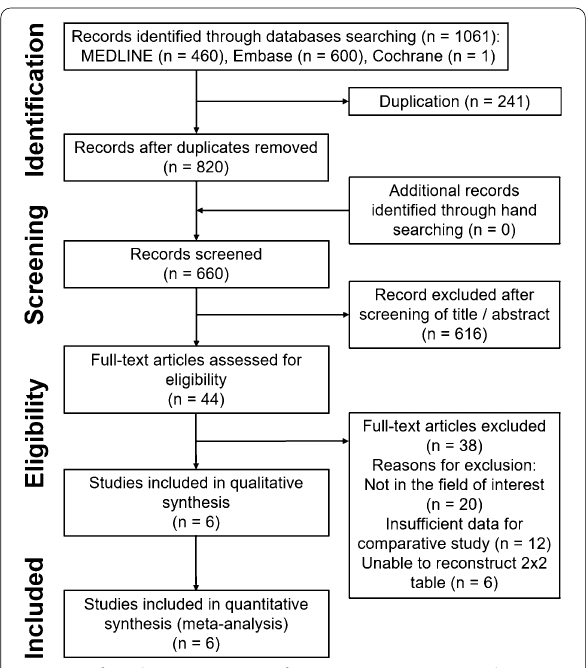
Fig. 1 Preferred Reporting Items for Systematic Reviews and Meta‑analyses (PRISMA) flow diagram for the identification